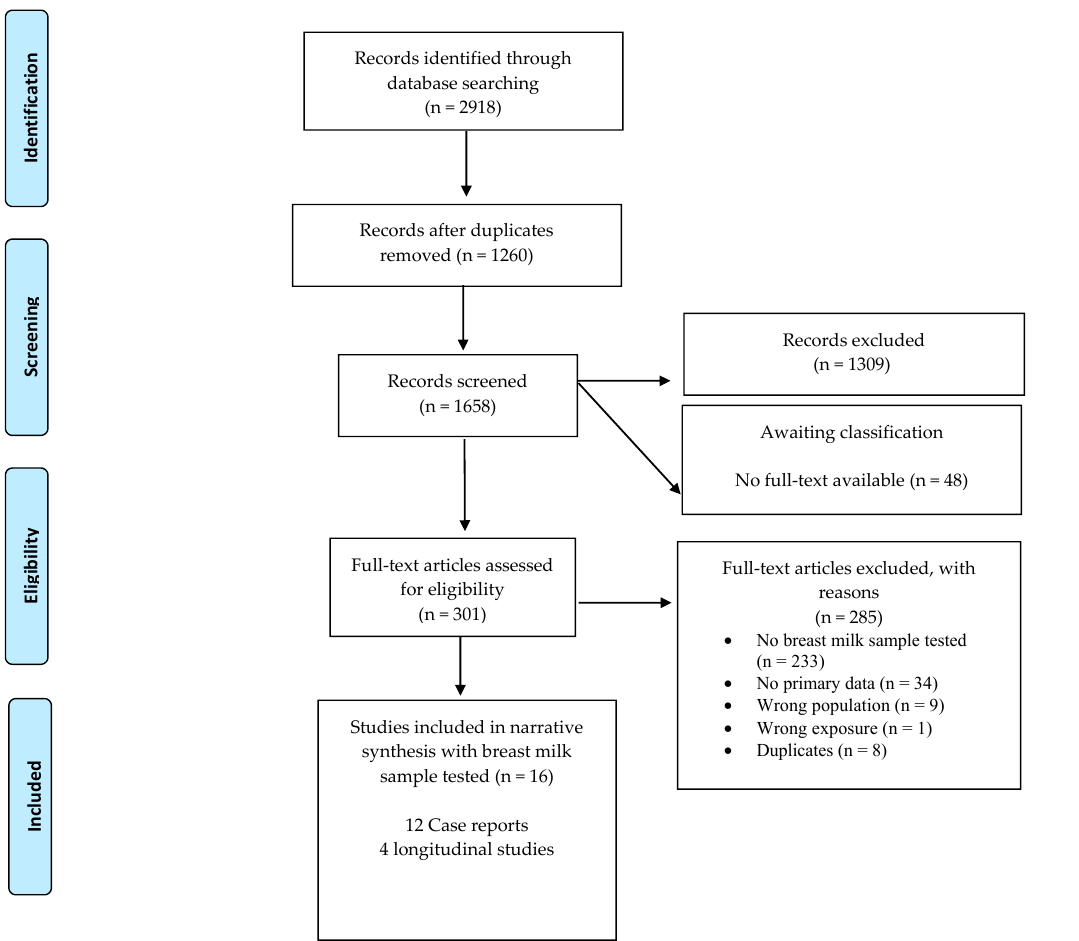
Figure 1. A schematic representation of the search strategy and selection of included